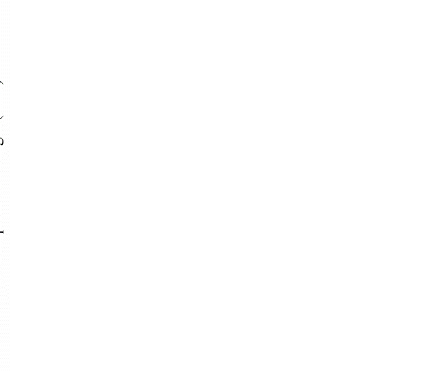
Figure 5. Effects of H 2 O 2 additions on flexural strength and compressive strength of SiC porous ceramics.